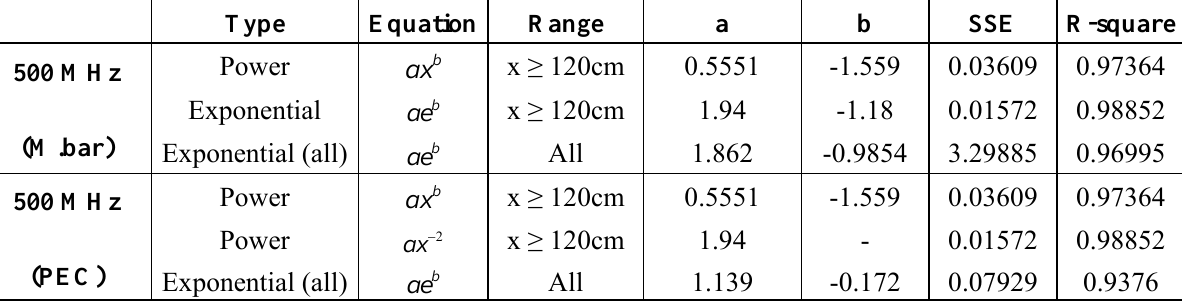
Table 1. Values that allow the best fit of the regression curves and parameters related to the quality of the